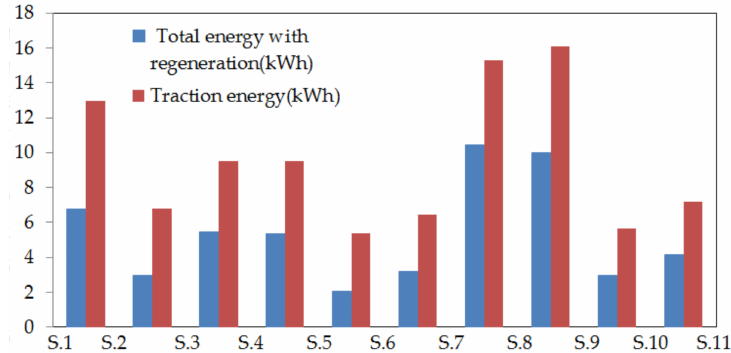
Figure 10. Energy consumption data among the stations.